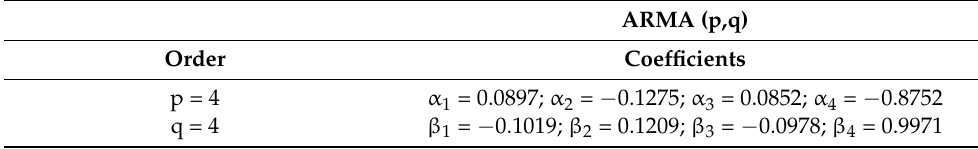
Figure 15. Relative differentiation of the solar radiation along a year (daily radiation averages). Table 7. Order and coefficients of the ARMA model (daily radiation averages).